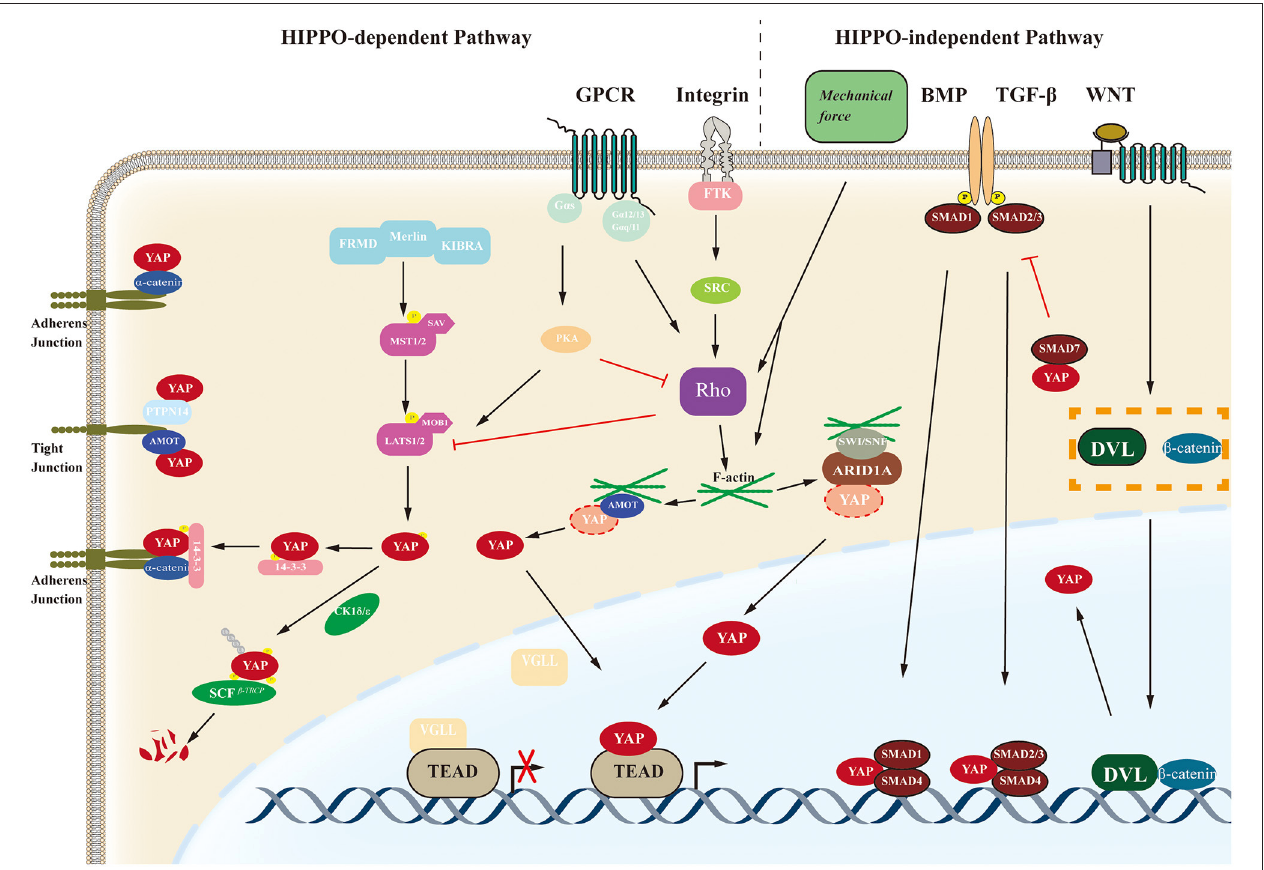
FIGURE 2 | Schematic of the YAP regulatory pathway. The biological function of YAP are regulated by the Hippo-dependent pathways (including the Hippo pathway and other cross-talk signal pathways such as GPCR-mediated pathways and Integrin-mediated pathways) and Hippo-independent pathways such as BMP, TGF- β , WNT, etc. YAP, yes-associated protein; GPCR, G protein-coupled receptors; BMP, bone morphogenetic protein; AMOT, angiomotin; FRMD, FERM domain-containing protein; MST1/2, Mammalian STE20-like protein kinase 1/2; SAV, Salvador family WW domain-containing protein; LAST1/2, Large tumor suppressor 1/2; MOB1, MOB kinase activator 1; FTK, fusion tyrosine kinases; TEAD, transcriptional enhancer associate domain; ARID1A, AT-rich interactive domain-containing protein 1A; SWI/SNF, switch/sucrose non-fermentable